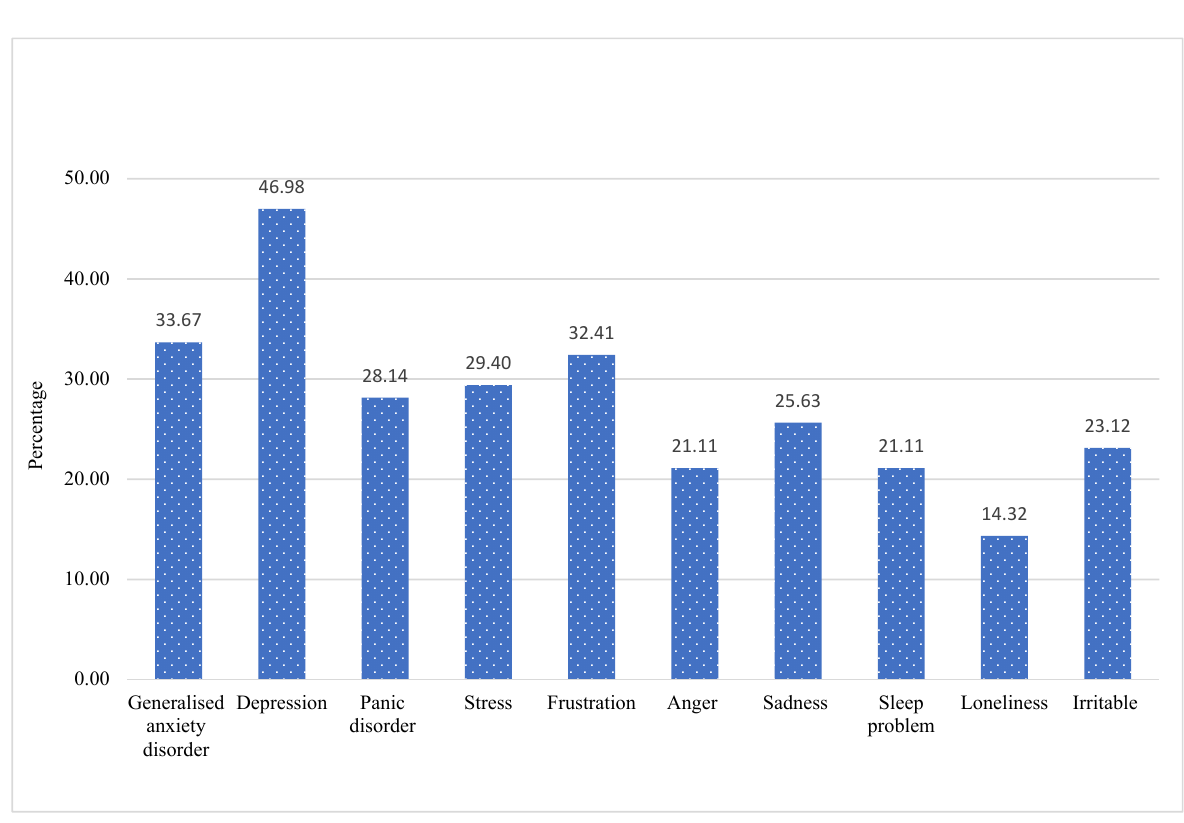
Figure 1. Mental health symptom experiences.